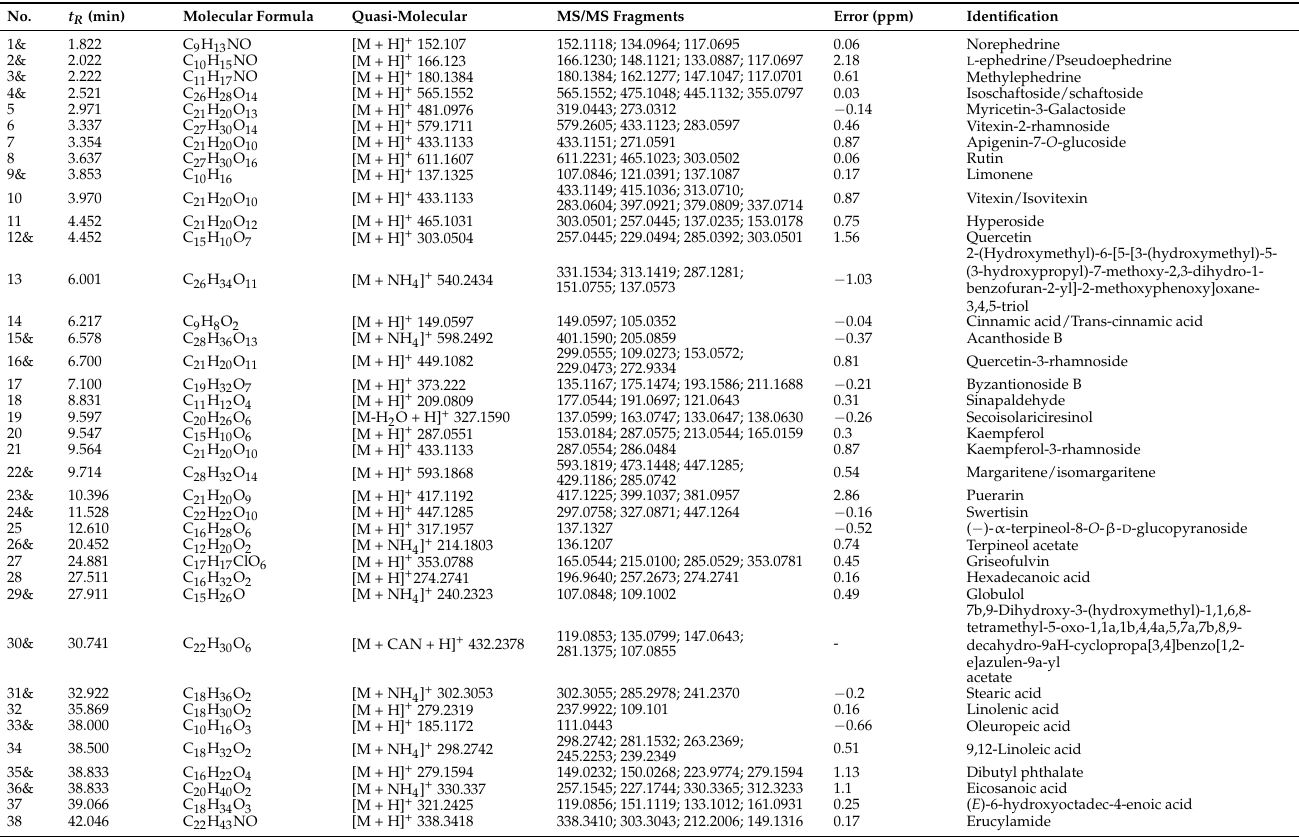
Table 2. Information on 38 compounds in P2 identified by